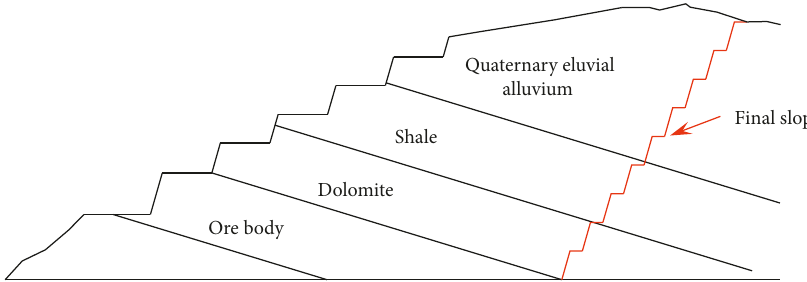
Figure 1: Geological profile of Baideng phosphorite.